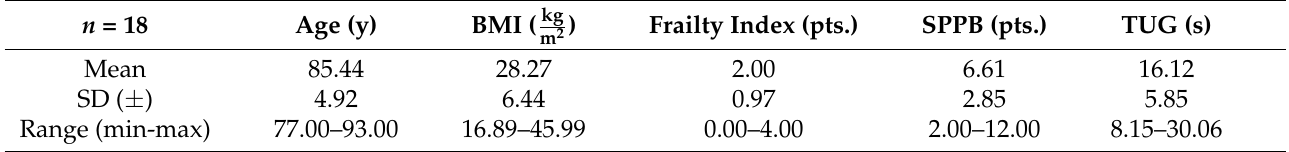
Table 2. The characteristics at the end of the study